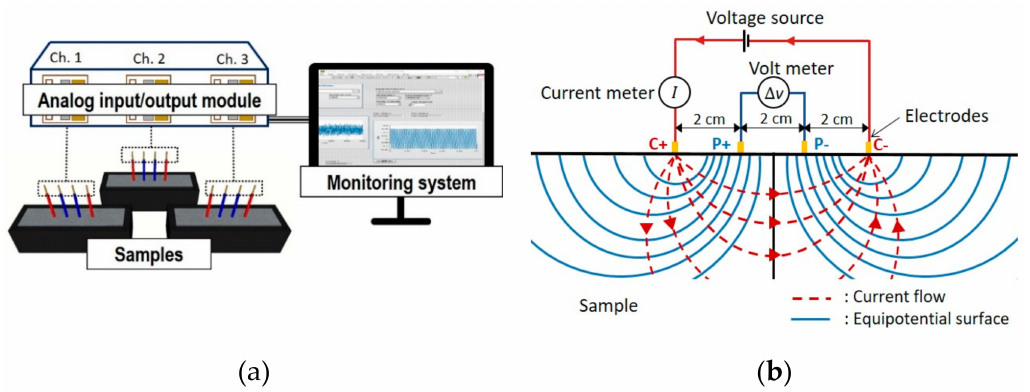
Figure 2. ( a ) Schematic experimental setup of electrical resistivity measurement; ( b ) schematic of the four-electrode method